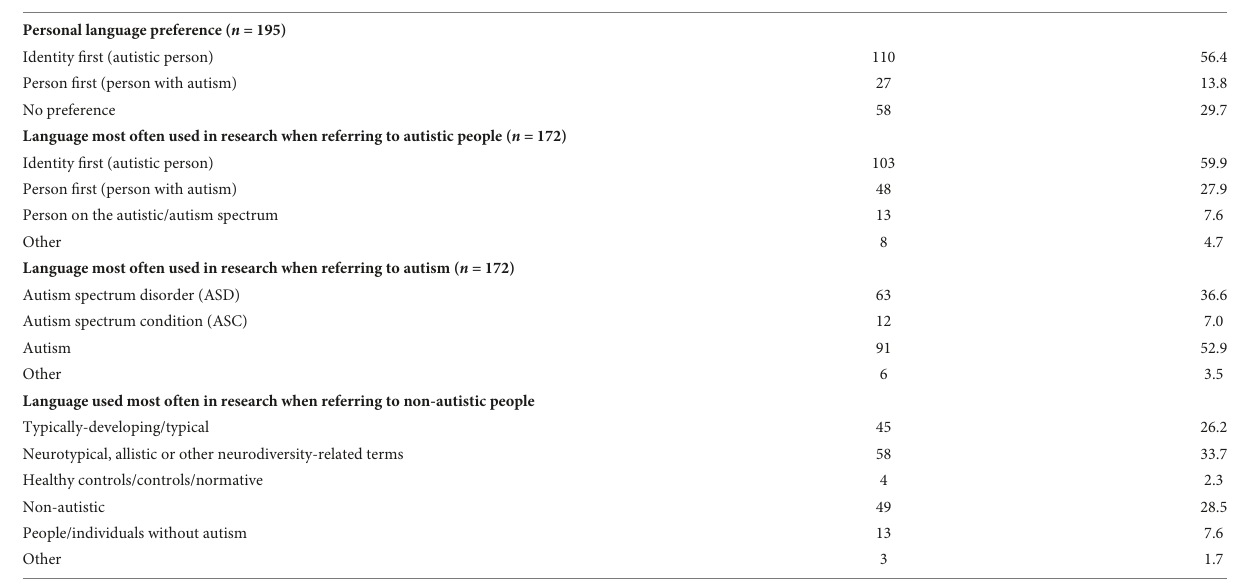
TABLE 5 Language preferences of researchers when referring to autism and autistic people.